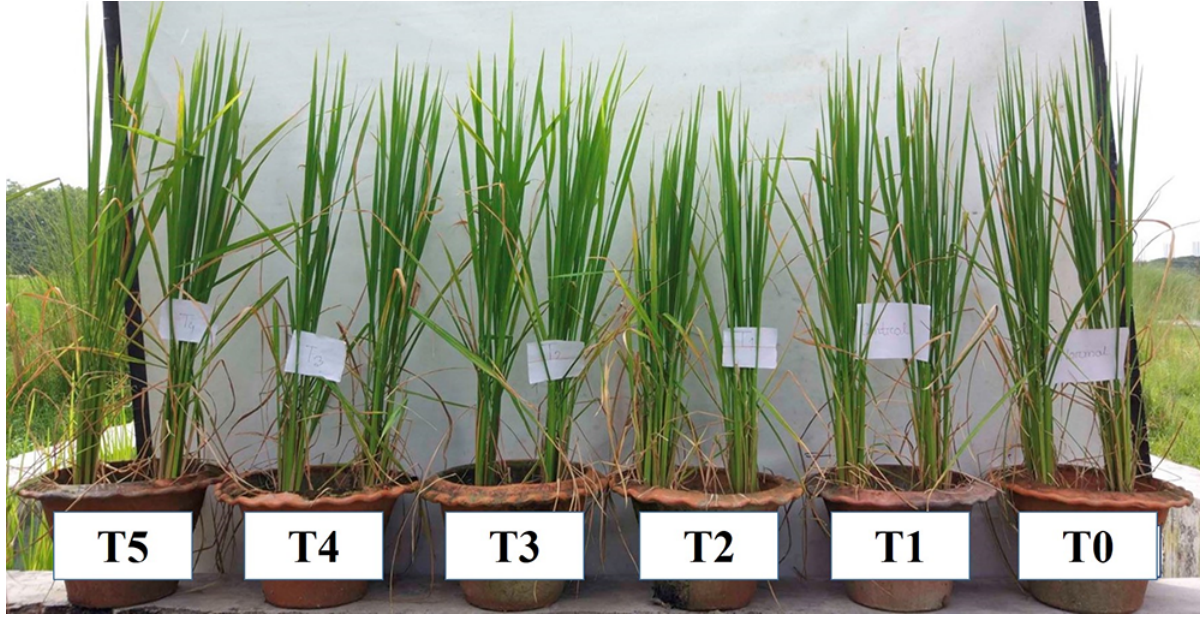
Figure 5 Photograph of the rice ‘Swarna’ influenced by boron under saline conditions. T0: Saline condition of EC 9.0 dS/m + no additional boron applied; T1: No saline condition + no additional boron applied; T2: Saline condition of EC 9.0 dS/m + boron application as solubor at a rate of 4.5 kg B ha − 1 ; T3: Saline condition of EC 9.0 dS/m + boron application as solubor at a rate of 5.9 kg B ha − 1 ; T4: Saline condition of EC 9.0 dS/m + boron application as solubor at a rate of 7.5 kg B ha − 1 ; T5: Saline condition of EC 9.0 dS/m + boron application as solubor at a rate of 10 kg B ha − 1 .